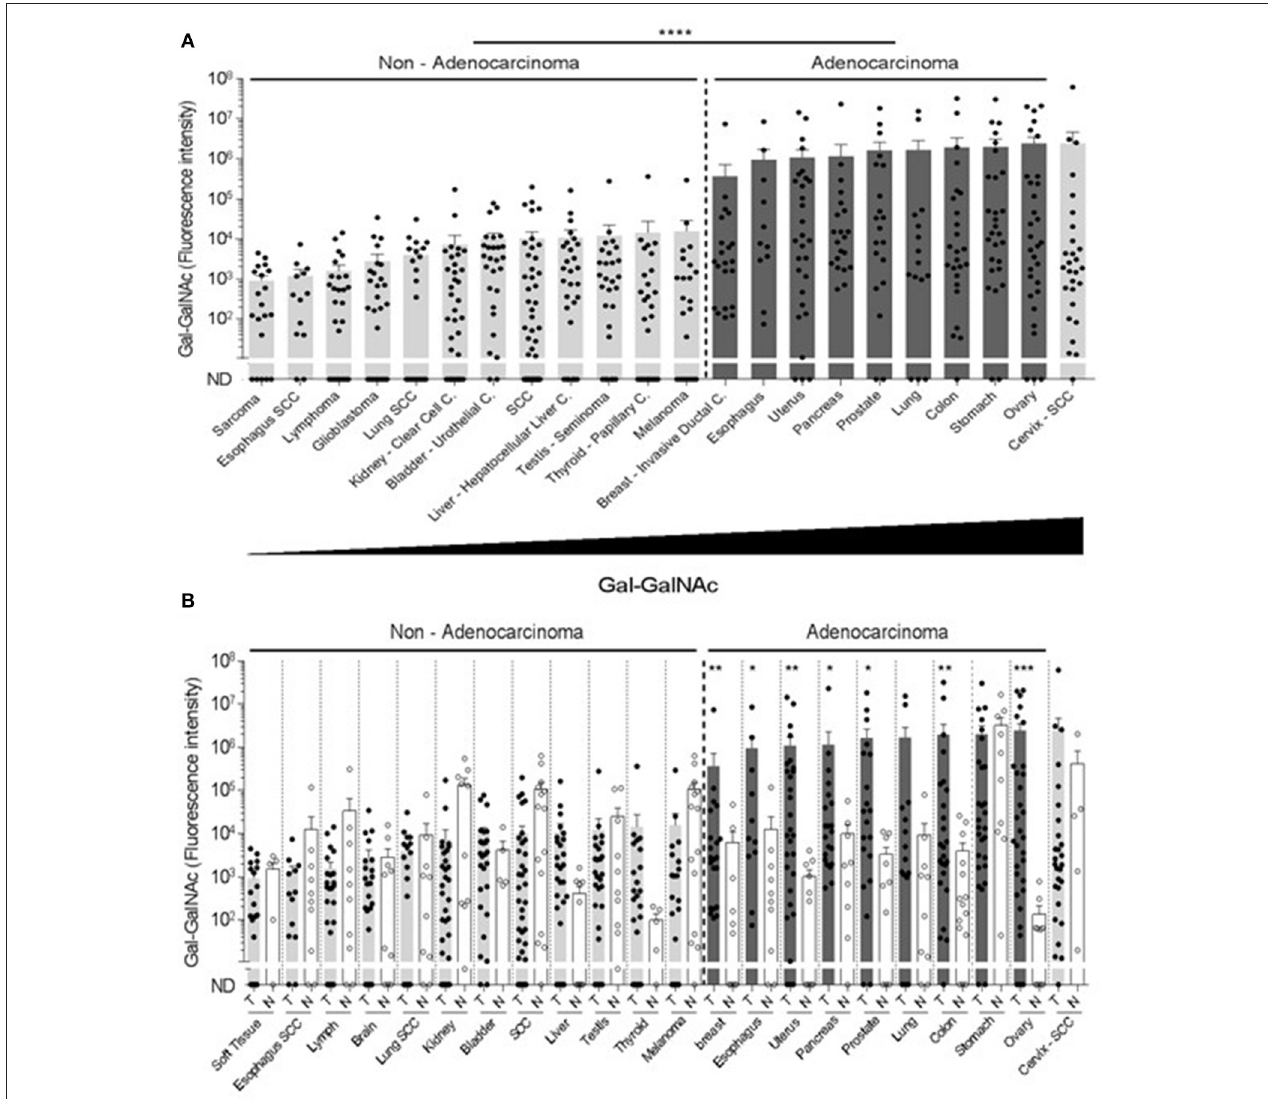
FIGURE 2 | High Gal-GalNAc levels are displayed in human adenocarcinomas. (A) Tumors were arranged according to increasing Gal-GalNAc levels. As can be seen, all examined adenocarcinomas (dark gray) displayed high levels of Gal-GalNAc. (B) Gal-GalNAc levels in the tumors (closed symbols) described in (A) were compared to those in the matching normal tissue controls (open symbols). As can be seen, Gal-GalNAc levels in 7 out of the 9 presented adenocarcinomas were statistically significantly higher than those measured in the matching normal control tissues The normal tissue controls for esophagus, lung and skin were used twice for the respective esophagus adenocarcinoma and squamous cell carcinoma (SCC): the respective lung adenocarcinoma and SCC, and for the melanoma and SCC. Each symbol represents the fluorescent intensity of a different sample. Error bars indicate mean ± SEM. * p < 0.05, ** p < 0.01, *** p = 0.0001 Two-tailed Mann-Whitney test. **** p < 0.0001 using two-tailed t